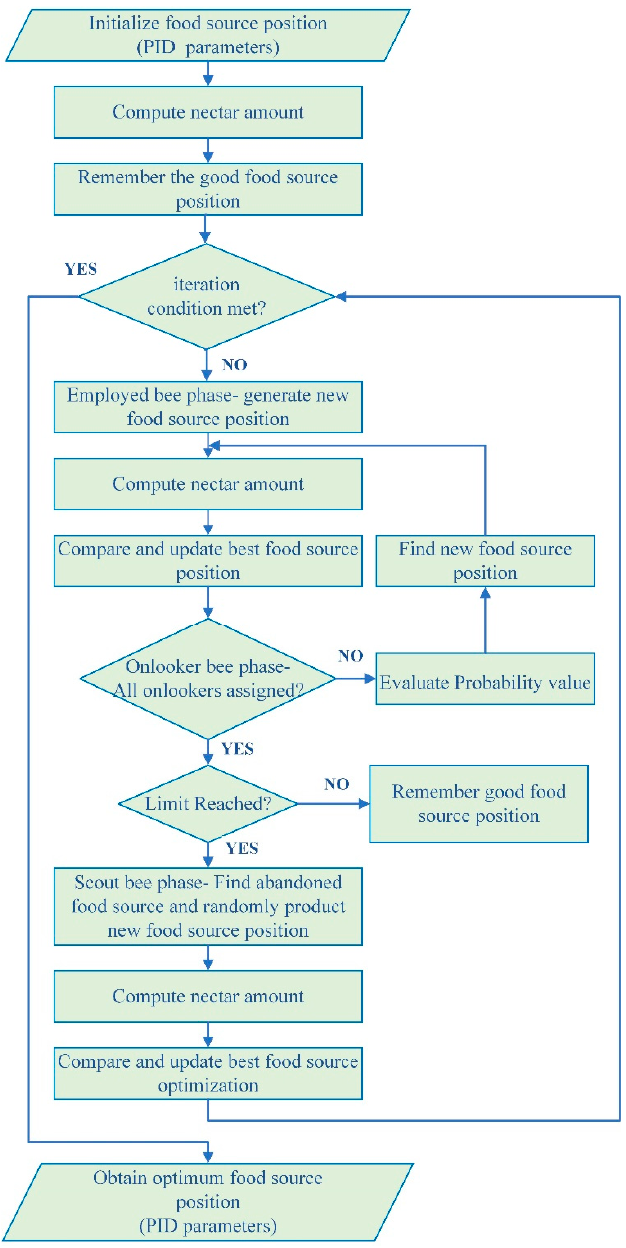
Figure 9. Flow of the algorithm.